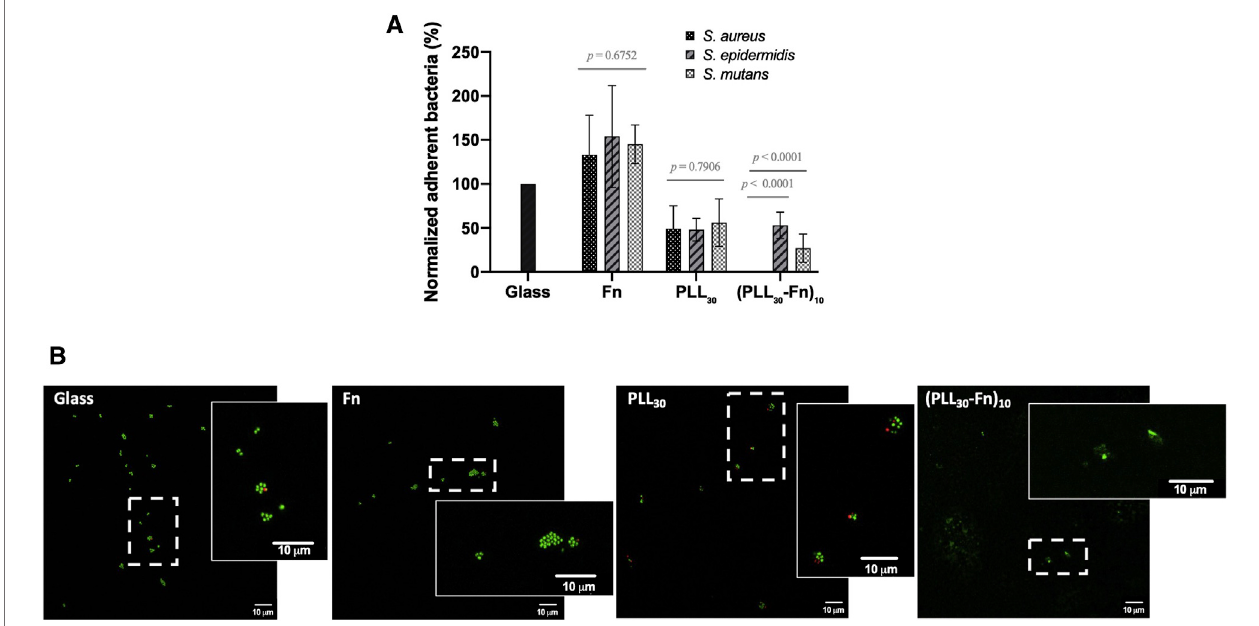
FIGURE 7 | Bacterial attachment on glass, Fn monolayer, PLL 30 monolayer, and (PLL 30 -Fn) 10 thin fi lms after 2 h of incubation. (A) Percentage of adherent S. aureus,S.epidermidis ,and S.mutans onFnmonolayer,PLL 30 monolayer,and(PLL 30 -Fn) 10 fi lmsnormalizedtobacteriaadheredonglass( n (cid:1) 7).No S.aureus arefound to adhere to (PLL 30 -Fn) 10 thin fi lms. Data are normalized for each strain to their respective glass control mean. Error bars indicate the standard deviation on the mean normalizeddata. (B) RepresentativeimagesofLIVE/DEADstainingofadherent S.aureus onglass,Fnmonolayer,PLL 30 monolayer,and(PLL 30 -Fn) 10 thin fi lms( n (cid:1) 3). The magni fi ed captions correspond to the area surrounded by dashed rectangles in the original images. Note: Green indicates live bacteria, red indicates dead bacteria. Scale bar (cid:1) 10 μ m. Statistically different at p <